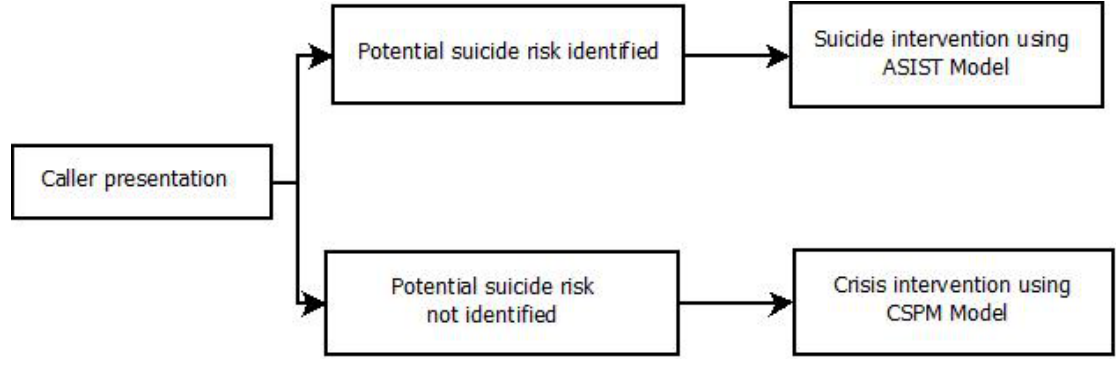
Figure 1. TCW training in decision making.